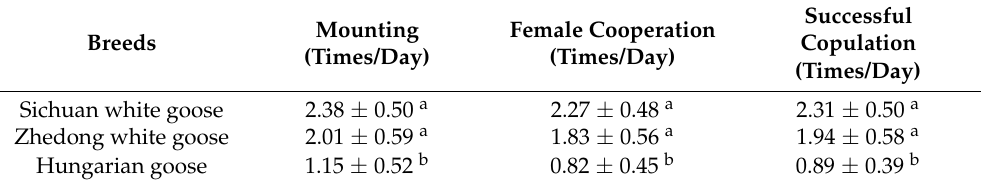
Figure 2. The typical mating behavior of geese. The mating behaviors were observed and recorded through the video. The typical behavior was as follows: ( A ) Mounting; ( B ) successful copulation on land; ( C ) successful copulation on water; ( D ) cooperative mating of female geese; ( E ) mating interference. Table 3. Frequencies of mating behaviors in the different goose breeds. Breeds